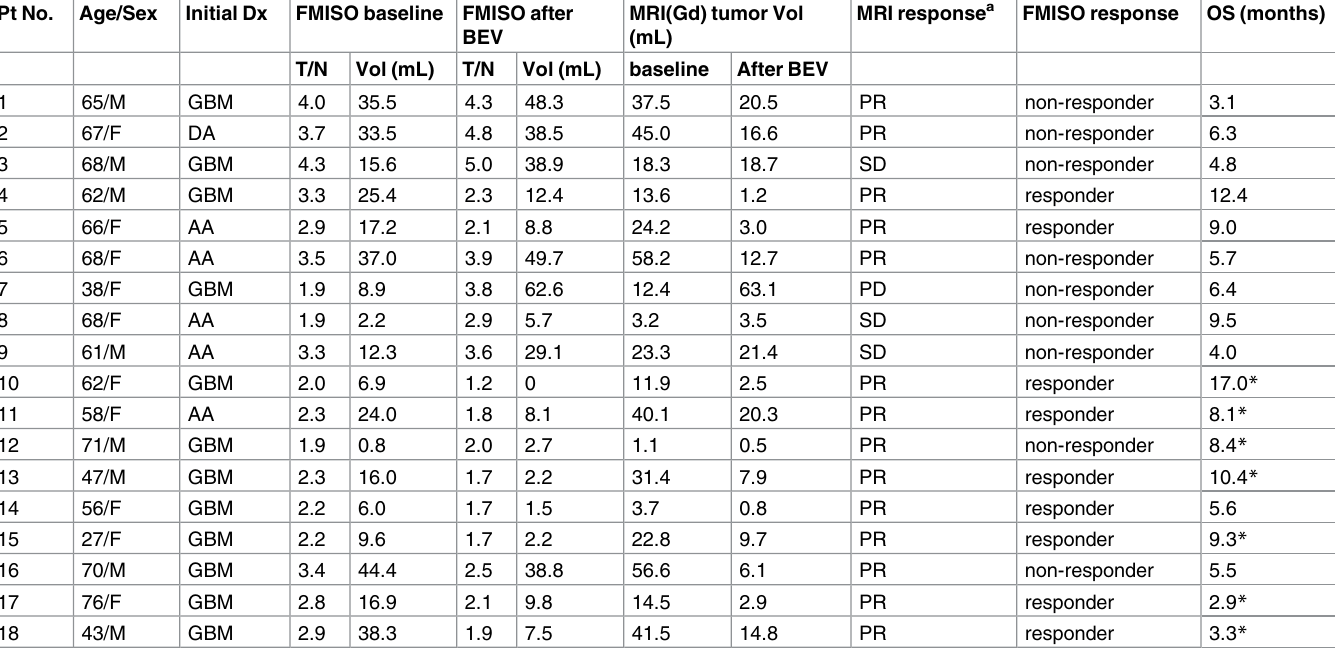
Table 1. Patient Characteristics, imaging findings, response evaluation, and prognosis. Pt